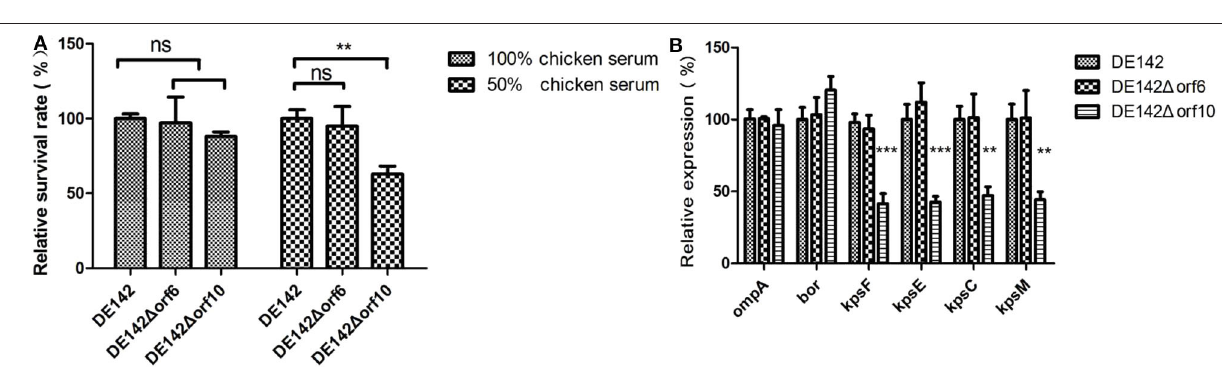
FIGURE 4 | Bacterial resistance to normal chicken serum. (A) The survival rate of the strains in chicken serum. Bacteria were incubated with SPF chicken serum at different dilutions at 37 ◦ C. After 30min, the remaining number of surviving bacteria was counted on LB plates. In the 100% chicken serum, the 100% repesents a 18% of inoculum of the WT; While in the 50% chicken serum, the 100% repesents a 32% of inoculum of the WT. DE142 1 orf10 showed significantly reduced resistance in 50% chicken serum. One-way analysis was performed for significance. ** P < 0.01. (B) Quantification of genes related to serum resistance. Expression levels of ompA , bor and K1 capsule-related genes ( kpsF , kpsE , kpsC, and kpsM ) in DE142 (WT) and mutant strains were measured by qRT-PCR. The acquired cycle threshold (CT) was normalized to the CT of the housekeeping gene dnaE . Data were presented as the mean ± SD of three independent experiments, with each experiment being comprised of four individual measurements. Unpaired T -tests were performed for significance. ** P < 0.01, *** P <